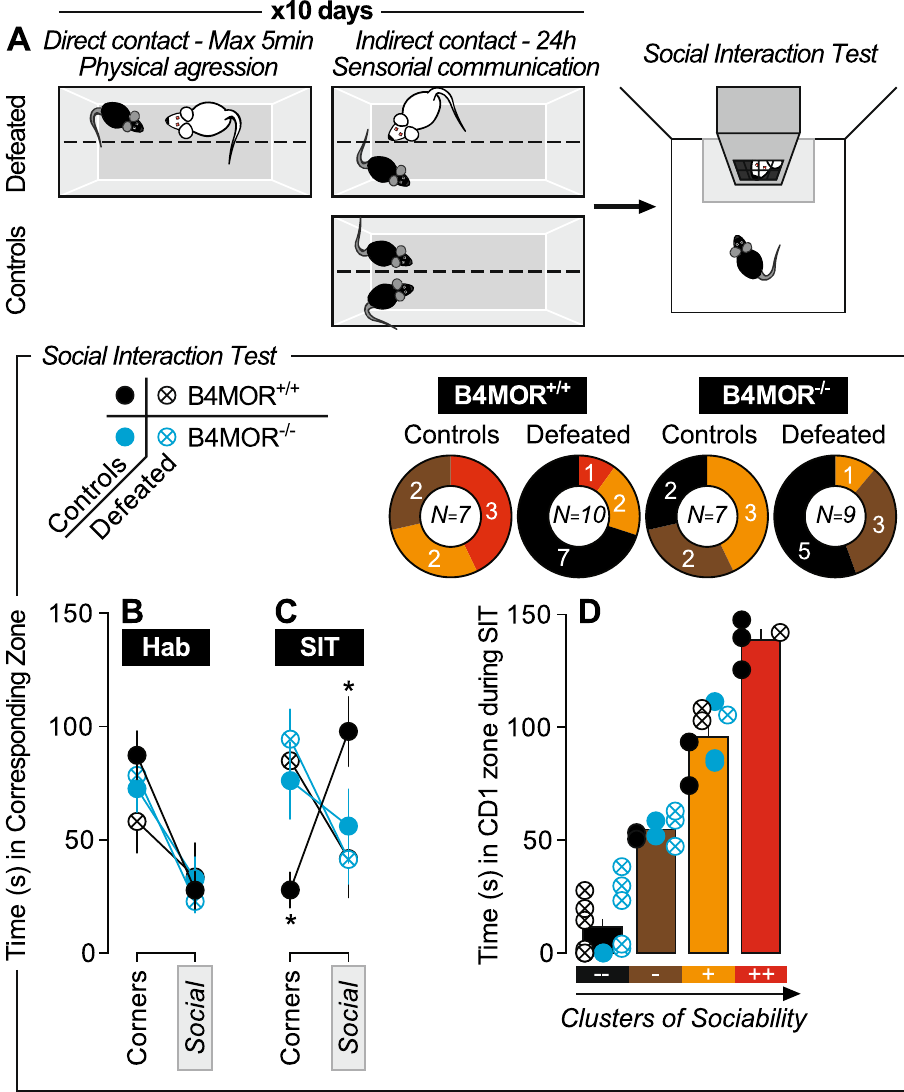
Figure 1. B4MOR −/− mice show disinterest for a CD1-social target in the chronic social defeat paradigm. ( A ) Schematic representation of the chronic social defeat and control procedures followed by the social interaction test (the gray part represents the social interaction zone). The wire mesh enclosure was empty during the habituation of the test and contained an unfamiliar CD1 mouse during the social interaction test. ( B ) During habituation, mice spent generally more time in the corners than in the zone around the wire mesh enclosure (future social zone). ( C ) During the social interaction test, B4MOR +/+ control (undefeated) mice spent more time in the social zone and less time in the corners than B4MOR +/+ defeated mice. ( D ) Mice were clustered in four distinct categories based on their time spent in the social zone during the social interaction test. The less sociable cluster did not include B4MOR +/+ control mice, but all the three other groups were represented. * P ’s < 0.05, B4MOR +/+ control mice versus B4MOR +/+ defeated mice. N’s =